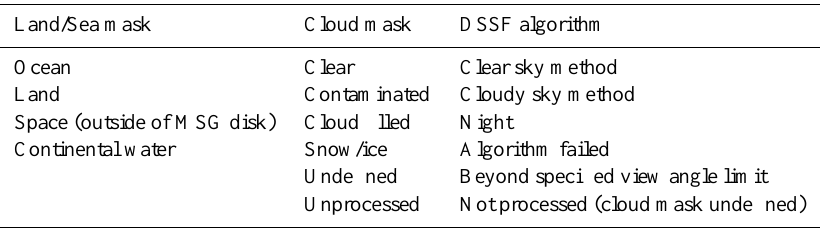
Table 1. DSSF quality flag description.